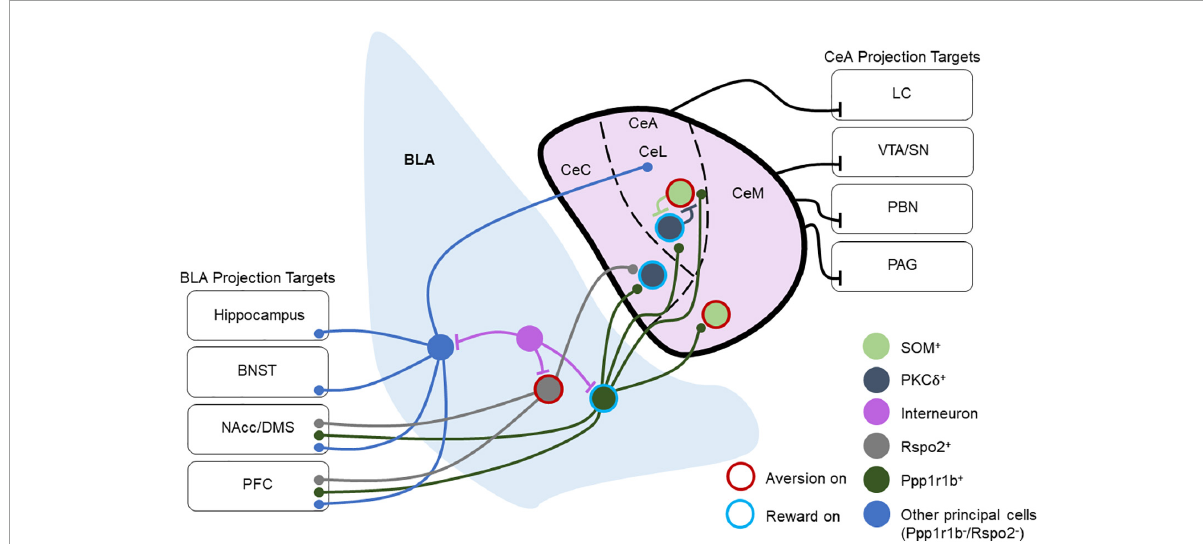
FIGURE1 Overview of basolateral amygdala (BLA) and central amygdala (CeA) connectivity and projection targets. This depicts a layout of multiple BLA and CeA cell types and their connectivity schemes in local and long-range circuitry. Cells are labeled as “Aversion on” or “Reward on” that has been tested experimentally. Ppp1r1b + BLA neurons target PKC δ + and SOM + neurons throughout the CeA, and they also project to the NAcc and PFC. Rspo2 + BLA neurons target PKC δ + neurons in the CeC and send projections to the NAcc and PFC. Other BLA principal neurons project to the CeA as well as to several other brain regions including the hippocampus, BNST, NAcc, DMS, and PFC. Within the CeL, SOM + , and PKC δ + populations reciprocally inhibit one another. CeM neurons also send long-range inhibitory projections to the VTA, SN, PBN, and PAG, while the CeL sends long-range inhibitory projections to the LC. Through these projections, the CeA regulates arousal, attention, movement, and defensive